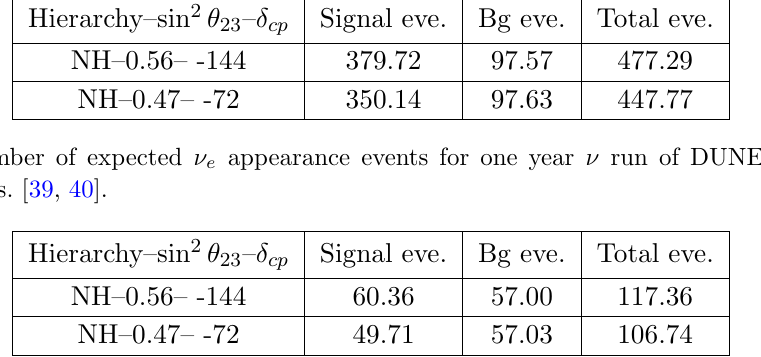
Table 8 . Number of expected (cid:22) (cid:23) e appearance events for one year (cid:22) (cid:23) run of DUNE, for the two solutions in refs. [39,